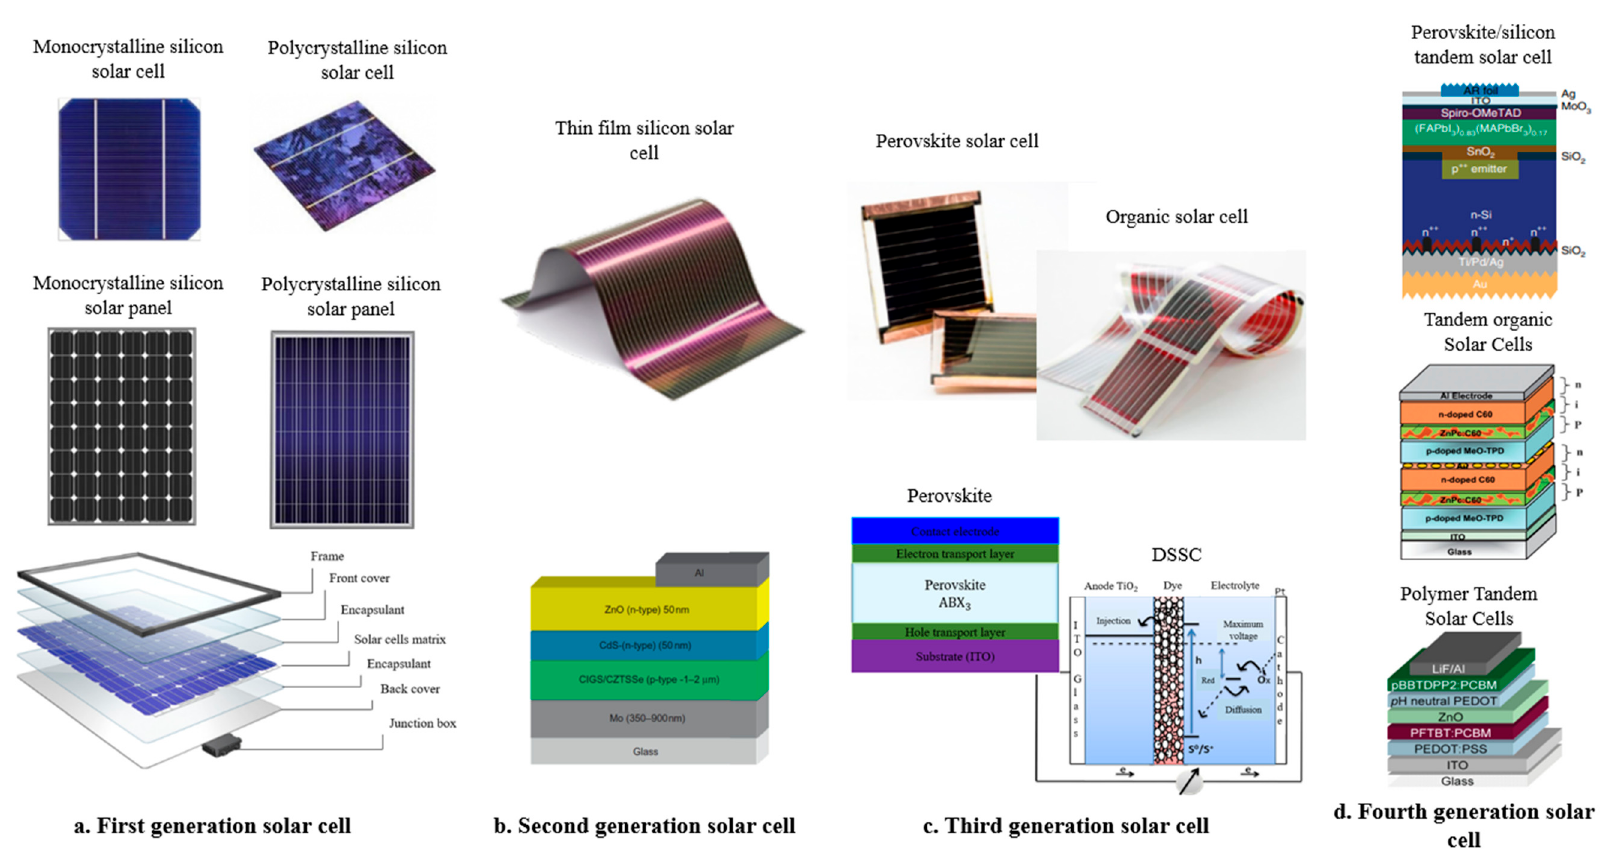
Figure 9. The four different generations of solar cells and their structures [74,76–80].